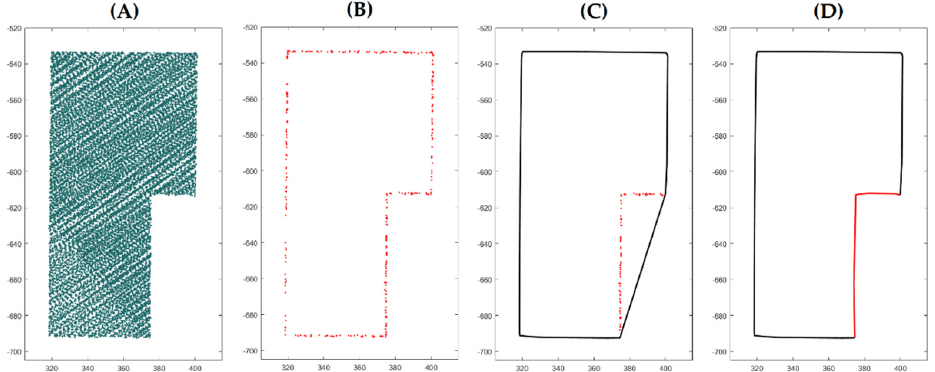
Figure 4. Initial building outline generation: ( A ) LiDAR point cloud of an individual building (2 − D view). ( B ) Extracted outermost points. ( C ) Convex polygon generated after applying convex hull algorithm only once. ( D ) The concave polygon generated by removing spurious line after applying the recursive convex hull algorithm on the deviated points.